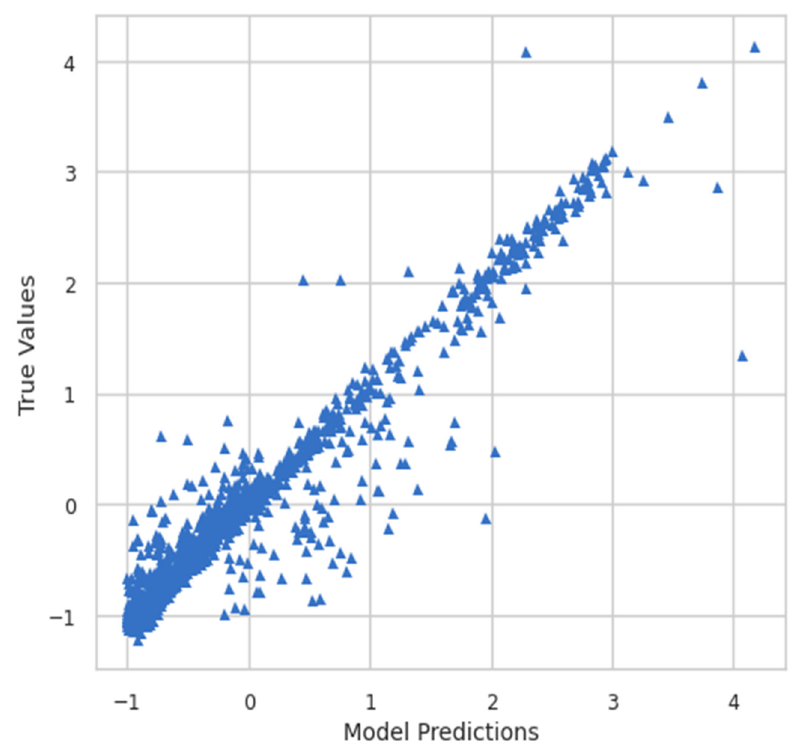
Figure 9. Inverse transform of model predictions vs. true values.